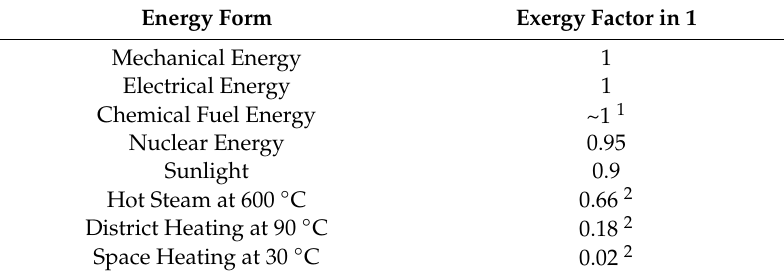
Table 1. Exergy factors for various energy forms; following